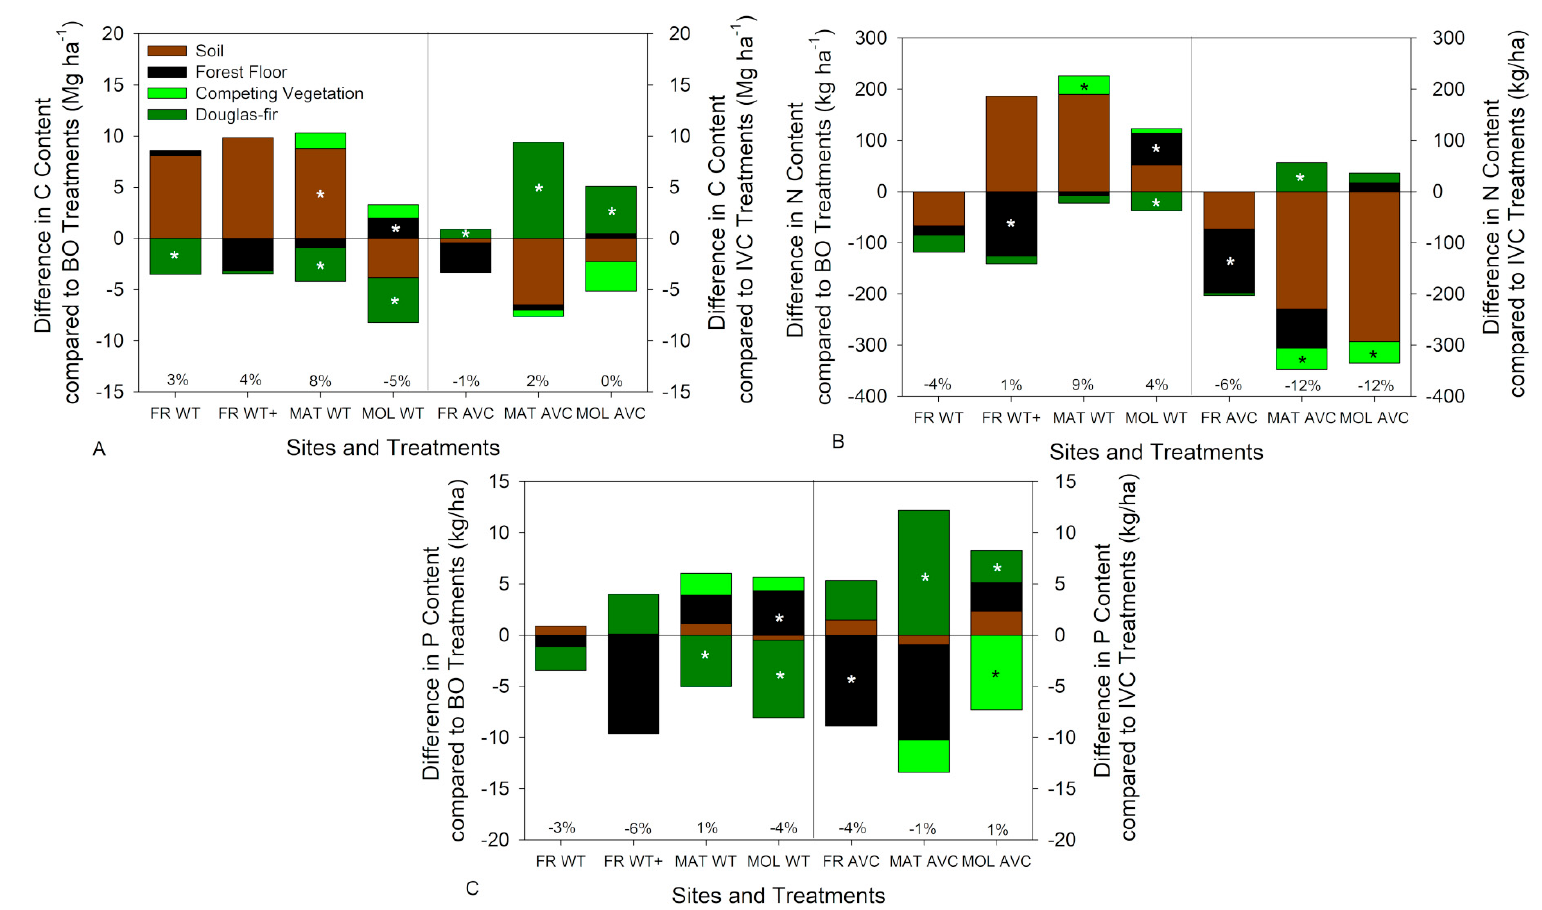
Figure 6. Net C ( A ), N ( B ), and P ( C ) nutrient pools in whole tree removal treatments (left frame: WT or WT+ minus BO treatment) and annual vegetation control (right frame: AVC minus IVC treatment) at Fall River (FR), Matlock (MAT), and Molalla (MOL). Asterisks denote significant differences from the BO or IVC treatments for a given study site. Values at the bottom of each graph are the total percent difference from the BO or IVC treatments.